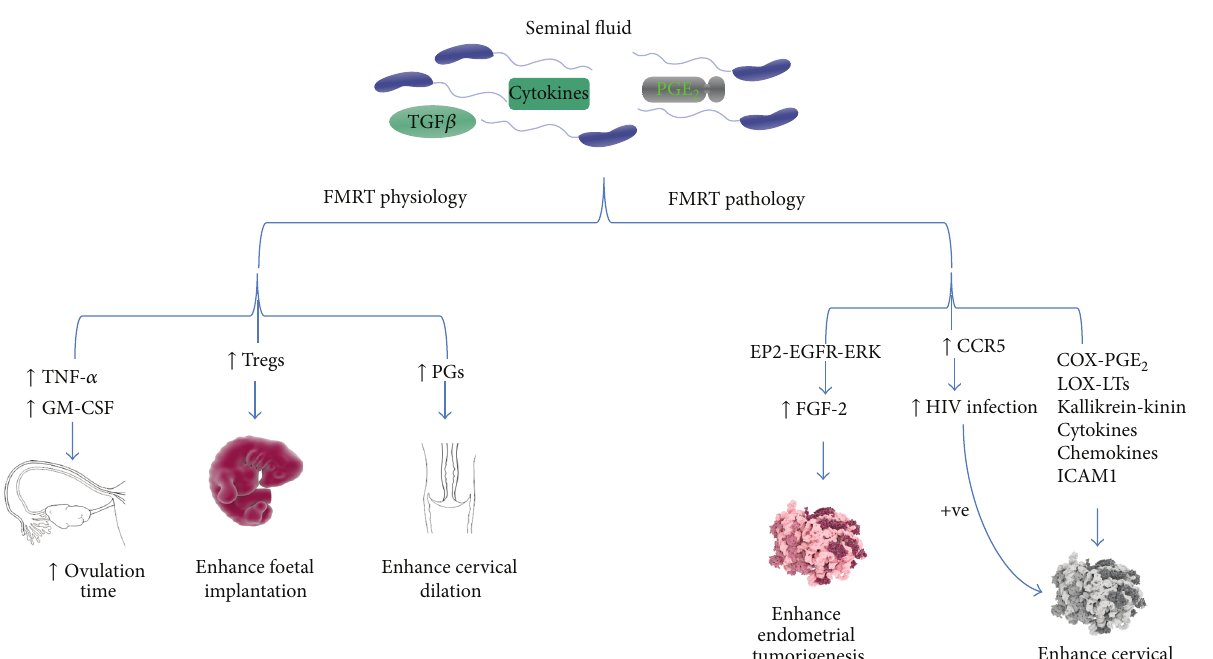
Figure 1: Schematic diagram showing the role of seminal fluid-mediated inflammation in the regulation of physiology and pathology of the female reproductive tract. SF has been shown to contain a wide variety of signaling molecules including cytokines, TGF 𝛽 , and PGE 2 . Exposuresofthefemalereproductivetract(FMRT)tothesemoleculescanimpactonthephysiologyandpathologyoftheFMRT.SFregulation ofTNF- 𝛼 andGM-CSFenhancesovulationprocessbyincreasingovulationtime.RegulationofTregspopulationpromotesmaternaltolerance and foetal implantation while SF-mediated regulation of PGs enhances cervical dilation during parturition. It has been established that SF can mediate pathologic conditions within the FMRT. In endometrial tumorigenesis, SF-mediated regulation of FGF-2 via the